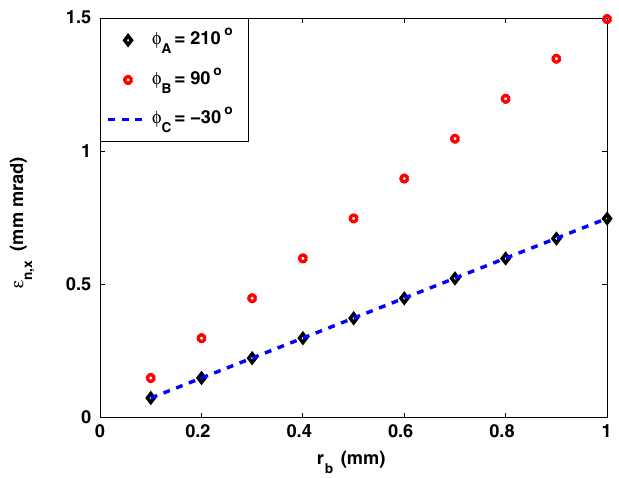
FIG. 14. Normalized rms projected emittance ( (cid:8) n;x ) for differ- ent bunch radius ( r b ) corresponding to rf phases (cid:4) A;B;C .